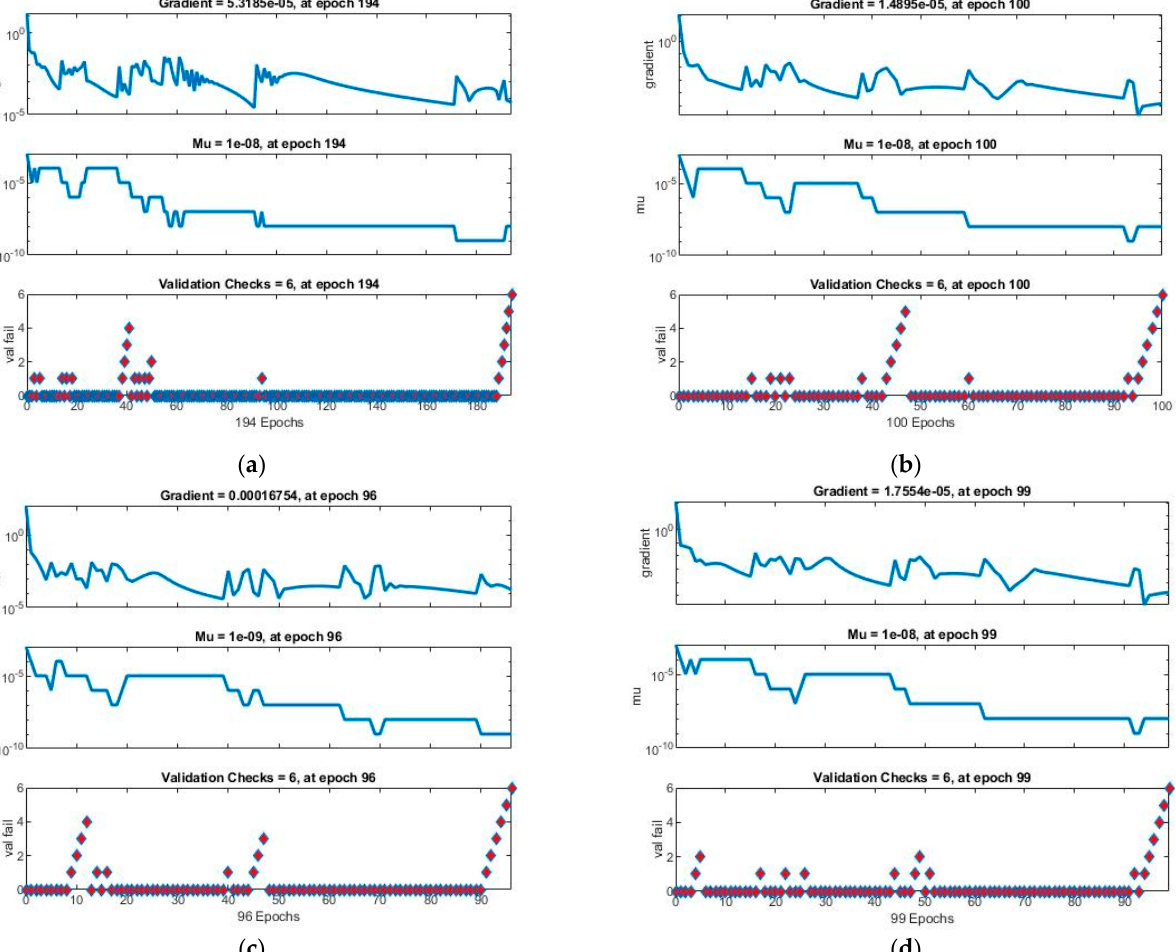
Figure 5. State transition containing gradient, step size, and validation checks of LMM-NNs for all four cases of the Dahl-based hysteresis model of piezoelectric actuator. ( a ) LMM-NNs Case 1. ( b ) LMM-NNs Case 2. ( c ) LMM-NNs Case 3. ( d ) LMM-NNs Case